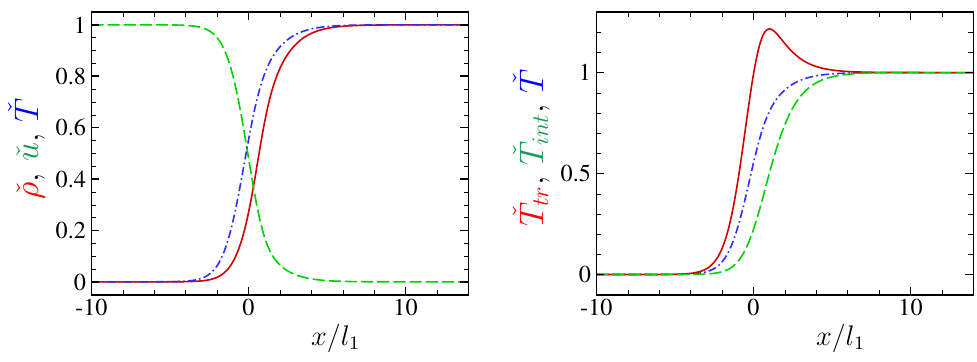
Figure 8. Profiles of ˇ ρ , ˇ u , ˇ T , ˇ T tr , and ˇ T int at M = 2 in the case of δ = 4, θ = 0.3, and Pr = 0.761 ( ν = − 0.449, µ b / µ = 1.669). In the left figure, the solid line indicates ˇ ρ , the dashed line ˇ u , and the dash-dotted line ˇ T ; in the right figure, the solid line indicates ˇ T tr , the dashed line ˇ T int , and the dash-dotted line ˇ T